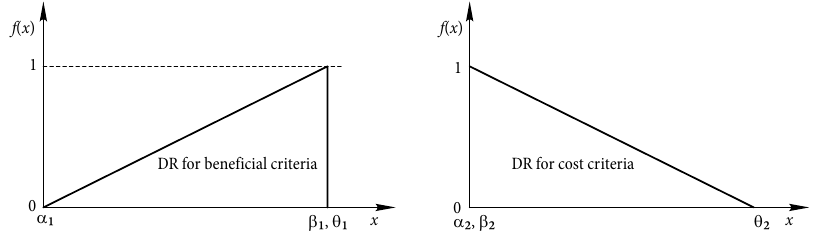
Fig. 4. Ideal design ranges for beneficial and cost